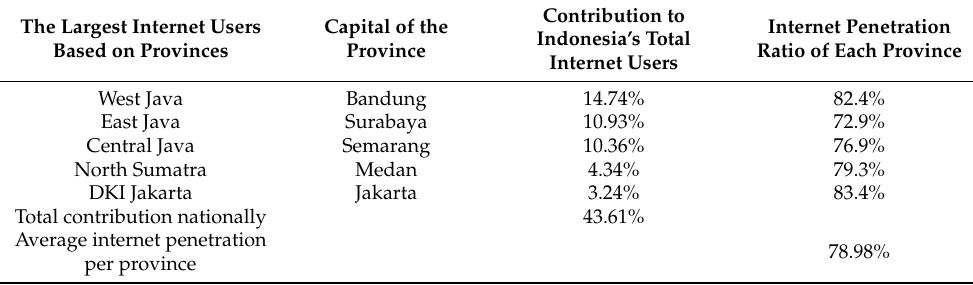
Table 1. The largest internet users in Indonesia by province capital